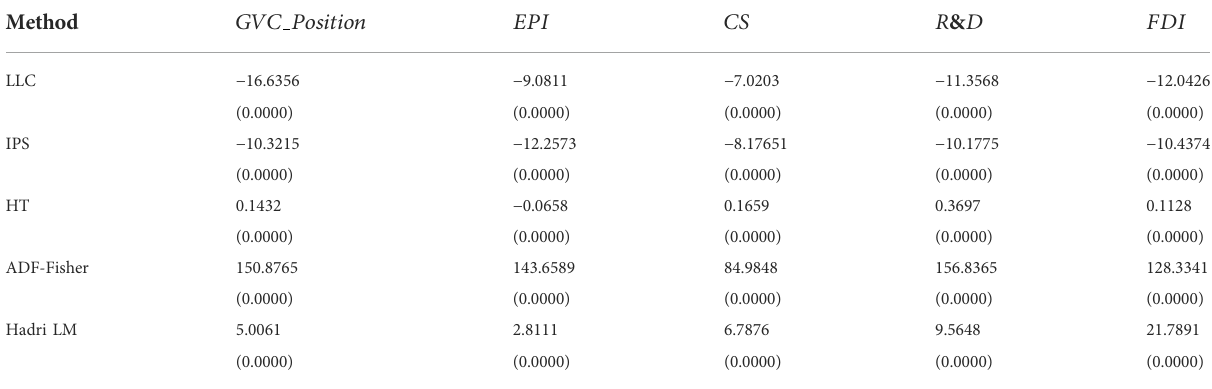
model. Therefore, we can assume that the variables in the model are one-order, single-integral stable variables. In order to further test whether there is a long-term stable equilibrium relationship between variables, the Pedroni and Kao cointegration test is used in this study to avoid false regression, and the results are shown in Table 4. Pedroni and Kao tests reject the original hypothesis at the level of the 1% cointegration relationship, which means there is a long-term stable equilibrium relationship between variables in the model, and the regression residuals of the model are stationary.